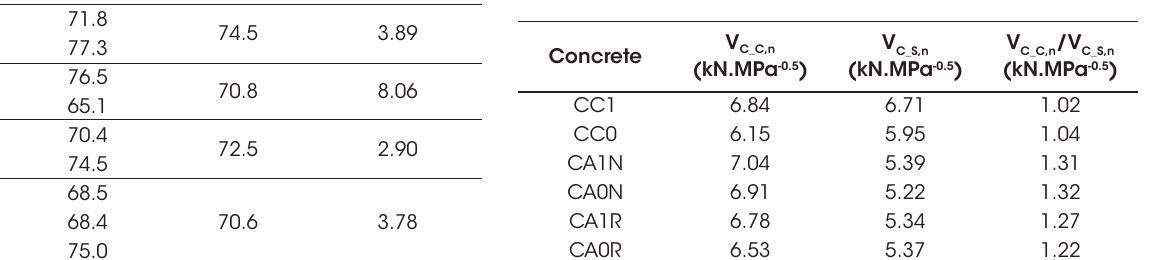
Normalized shear resistance attributed to concrete of beams with and without transverse reinforcement